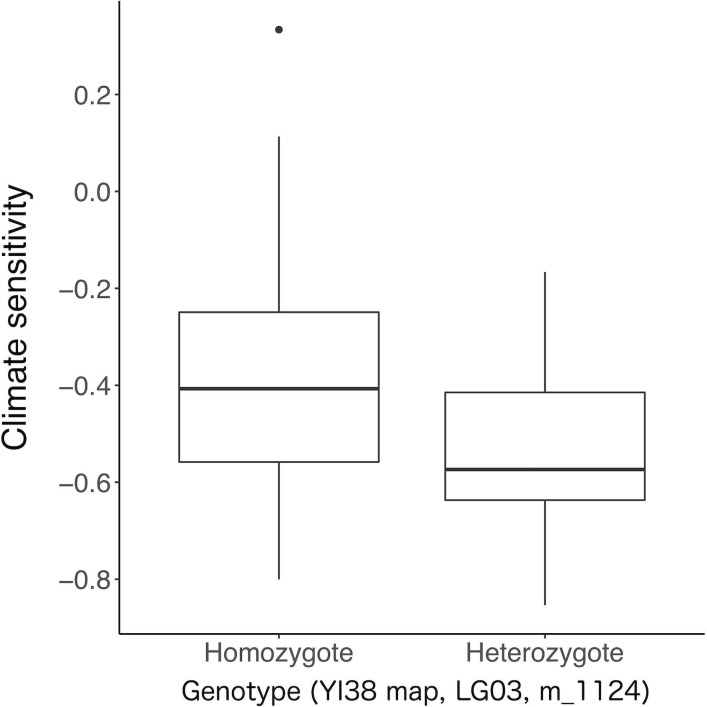
Difference in climate sensitivity between the marker genotype of the strongest QTL identified for drought sensitivity at the Chiba site.